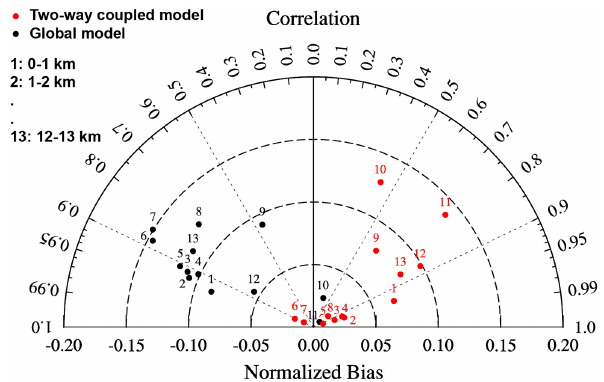
Figure 7. Correlation and mean normalized bias of modeled CO with respect to HIPPO measurements throughout the HIPPO cam- paigns, for individual vertical layers (e.g., 0–1km, 1–2km).